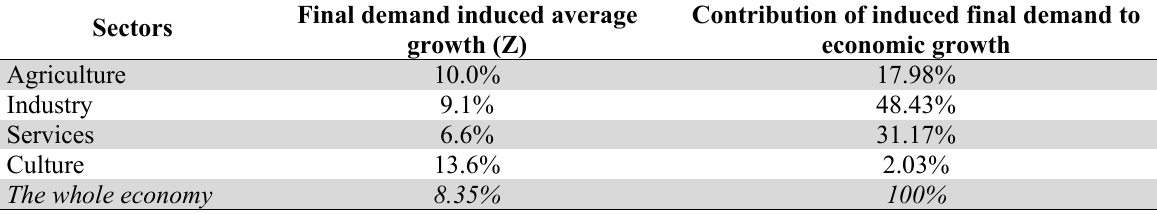
Induced final demand of each product sector’s contribution to economic growth